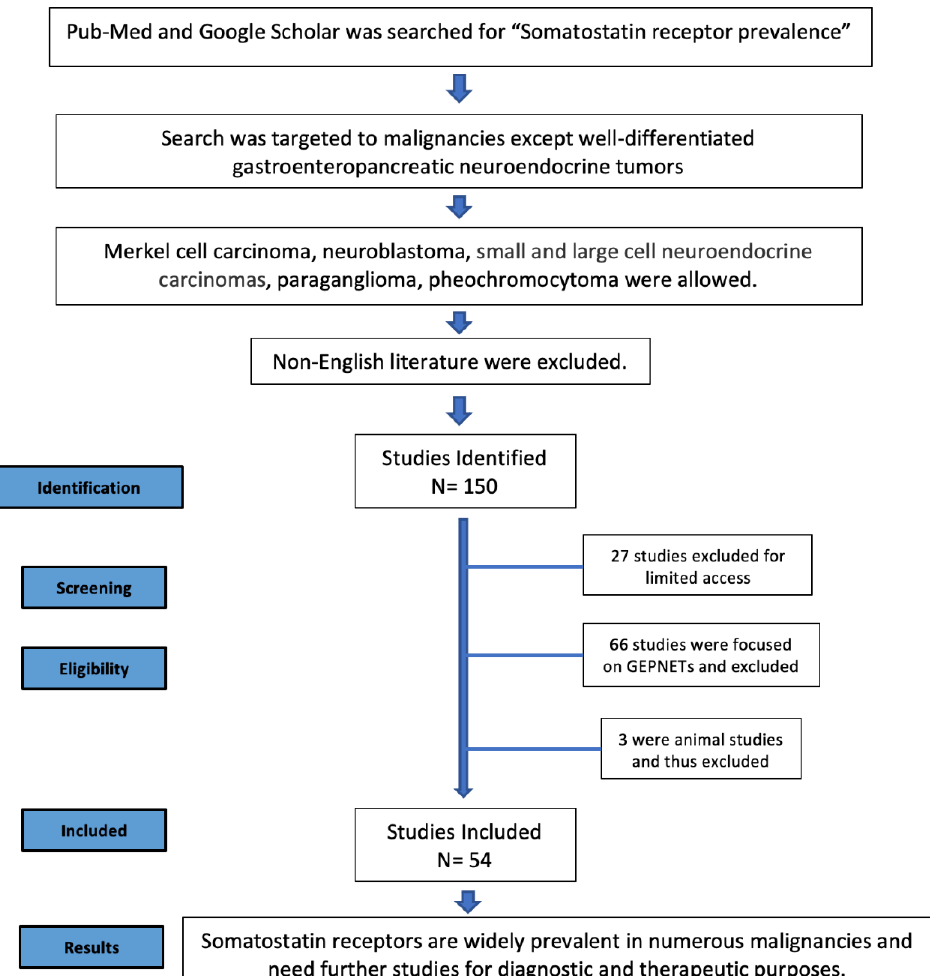
Figure 2. PRISMA flow diagram.